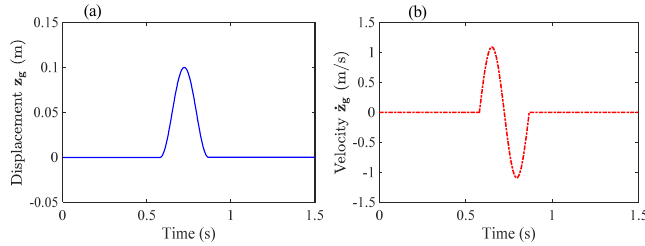
Figure 8. Bump input from the ground: ( a ) displacement excitation; ( b ) speed excitation.